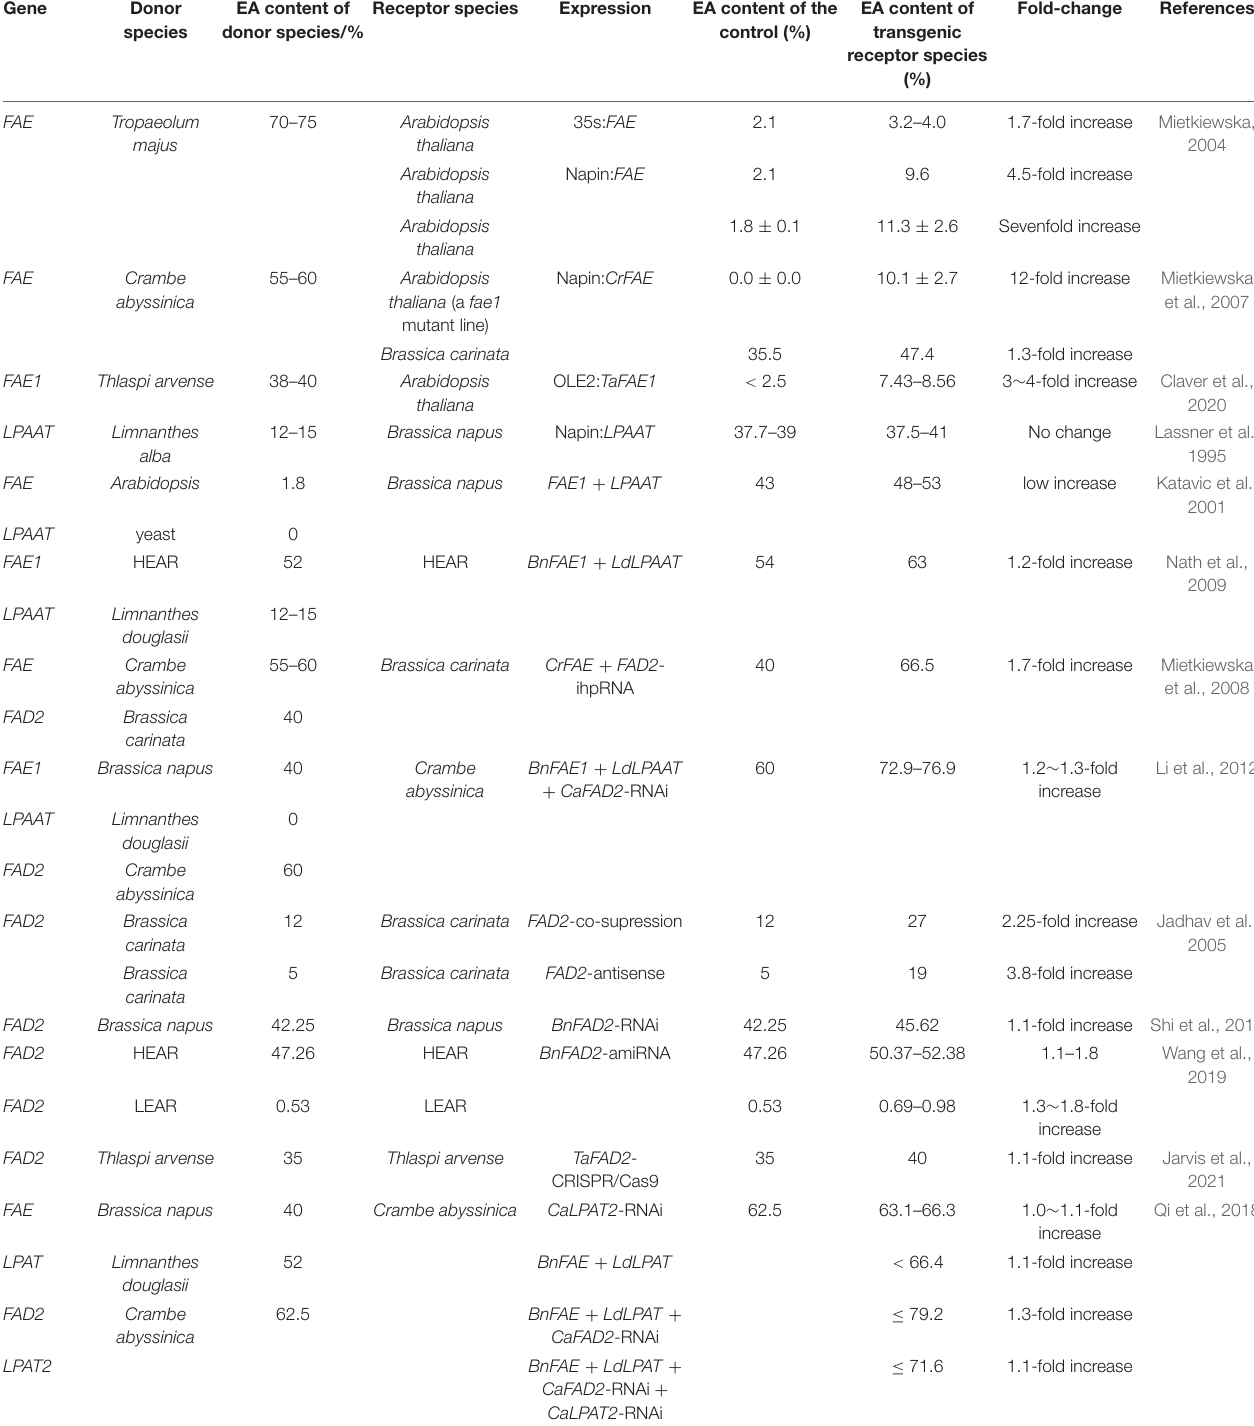
TABLE 2 | Comparison of research on improving EA content by means of genetic engineering in Brassicaceae